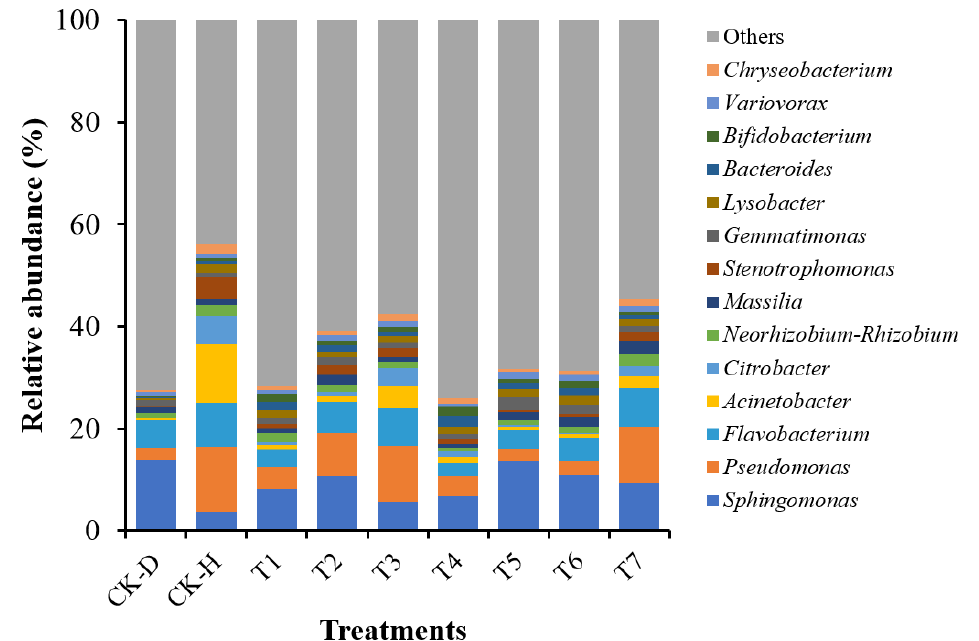
Figure 5. Relative abundance bar plots for 15 most dominant bacterial genera under different treatments (n = 3/treatment). Disease control (CK-D), healthy control (CK-H), single-strain Lysobacter antibioticus 13-6 (T1), single-strain L. capsici ZST1-2 (T2), single-strain Bacillus cereus BT-23 (T3), intra- genus co-culture of L. antibioticus 13-6 + L. capsici ZST1-2 (T4), inter-genus co-culture of L. antibioticus 13-6 + B. cereus BT-23 (T5), microbial consortia B. cereus BT-23 + L. antibioticus 13-6 + ZST1-2 (T6), and commercial fungicide Kejia (T7).